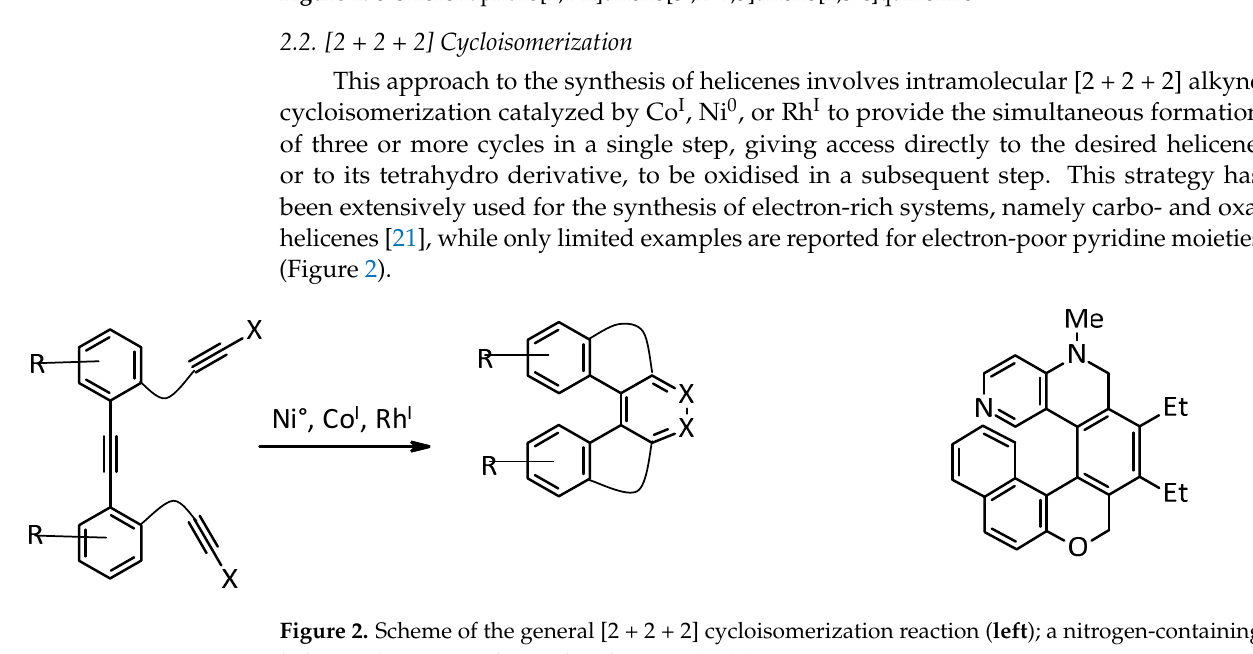
Figure 1. 8-chloronaphtho[2,1-h]thieno[3’,2’:4,5]thieno[2,3-c]quinoline.